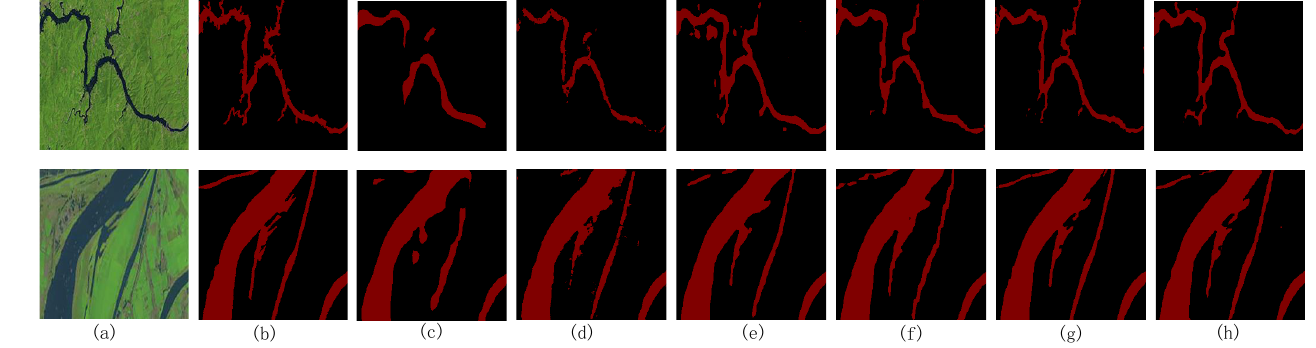
Figure 10. The comparison experiments of water domain segmentation. ( a ) Image; ( b ) label; ( c ) FCN8sAtOnce; ( d ) Segnet; ( e ) Deeplabv3+; ( f ) PSPNet; ( g ) UNet; ( h ) Our